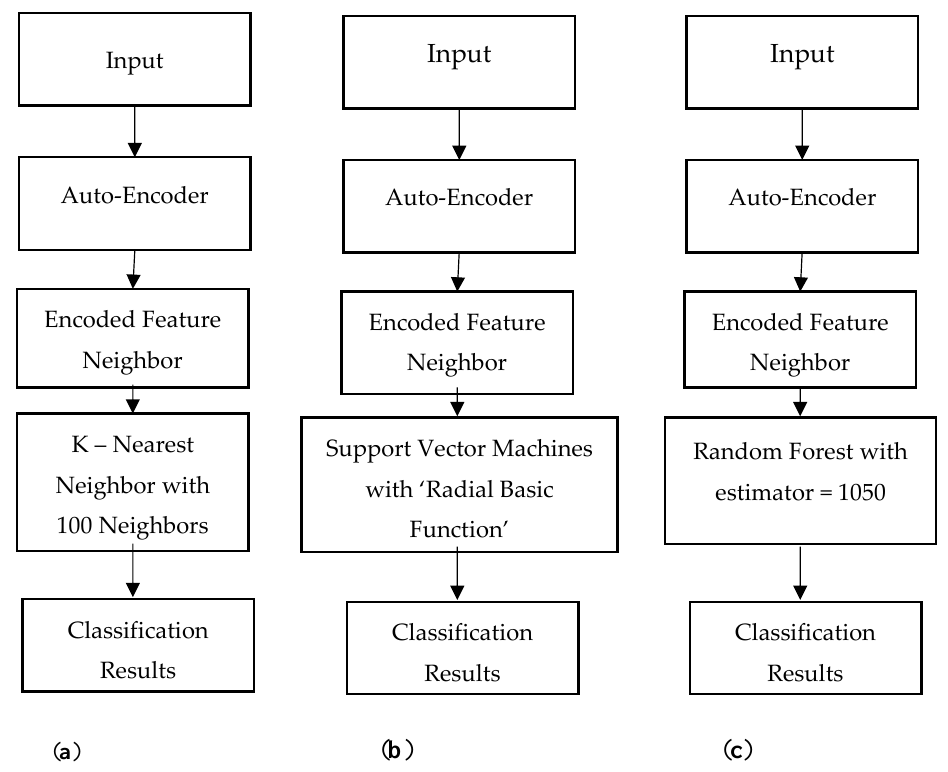
Figure 2. Flow chart of the proposed algorithm. ( a ) Autoencoder and KNN. ( b ) Autoencoder and SVM. ( c ) Autoencoder and RF.